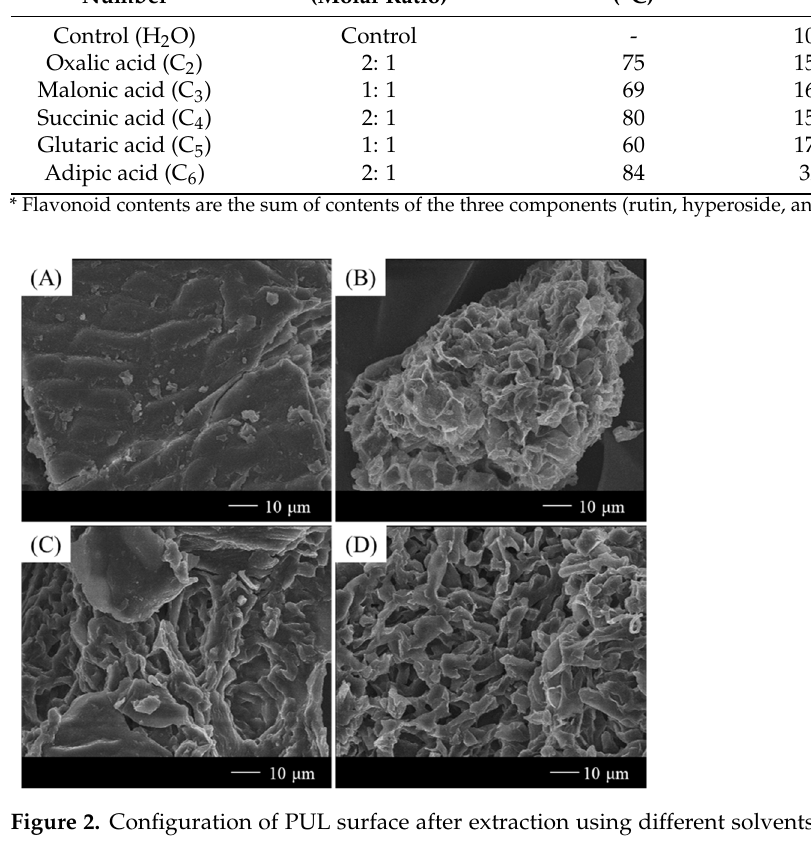
Table 1. Extraction efficiency of flavonoids from PUL .